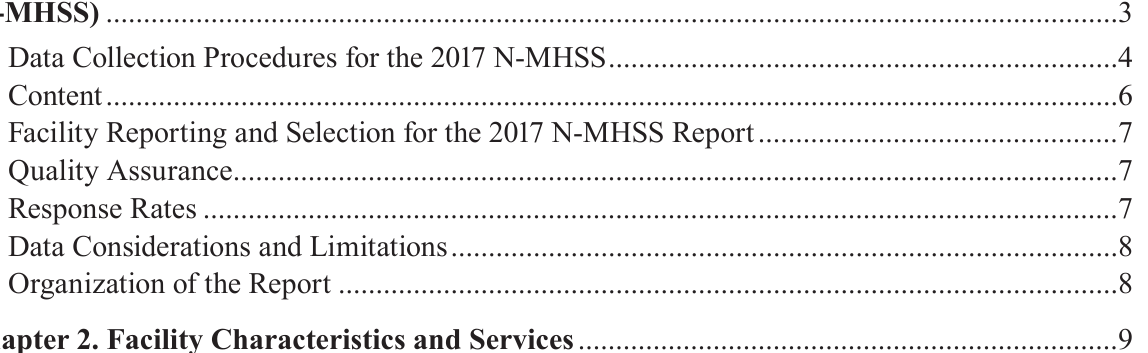
Chapter 1. Description of the National Mental Health Services